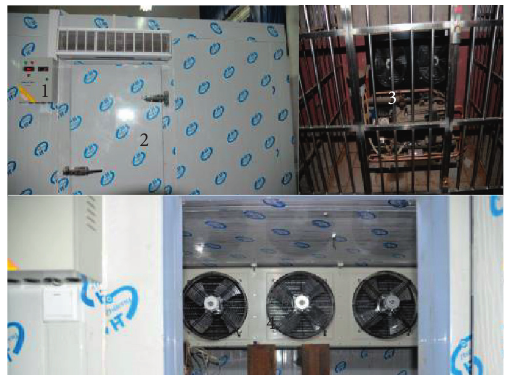
Figure 2: External environment simulation system. 1: temperature control system, 2: appearance of the incubator, 3: refrigerator, and 4: interior of the incubator.